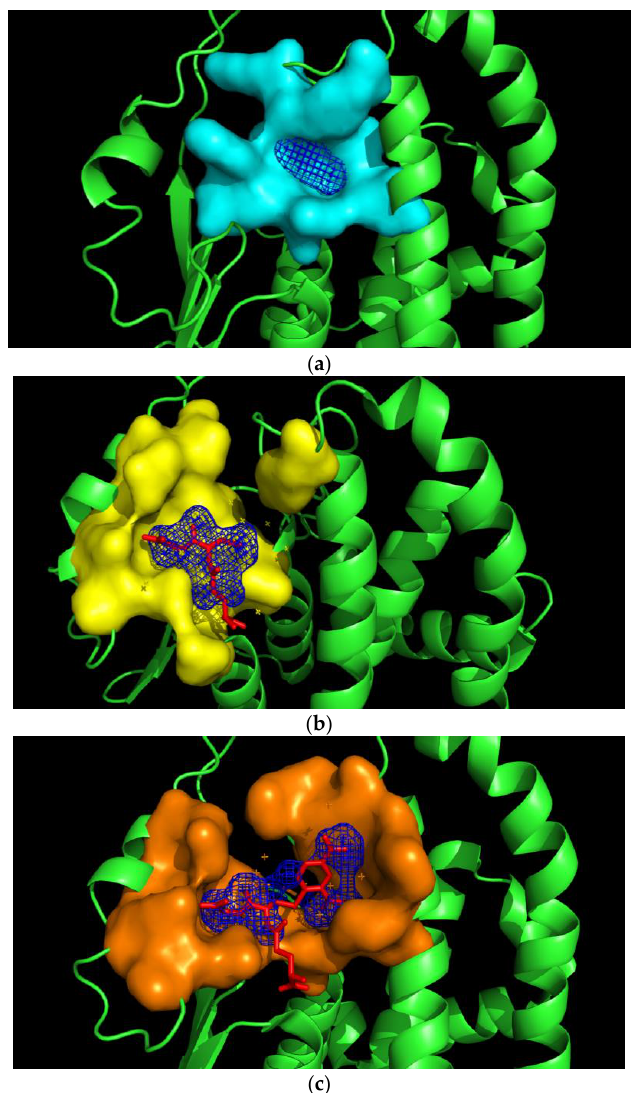
Figure 7. ( a ): The cavity volume of the ligand-free human GSTM1-1. ( b ): The cavity volume of the human GSTM1-1 in complex with GSH. ( c ): The cavity volume of the human GSTM1-1 in complex with GSH and CDNB. Figures have been created with KVFinder (PyMOL plug-in).